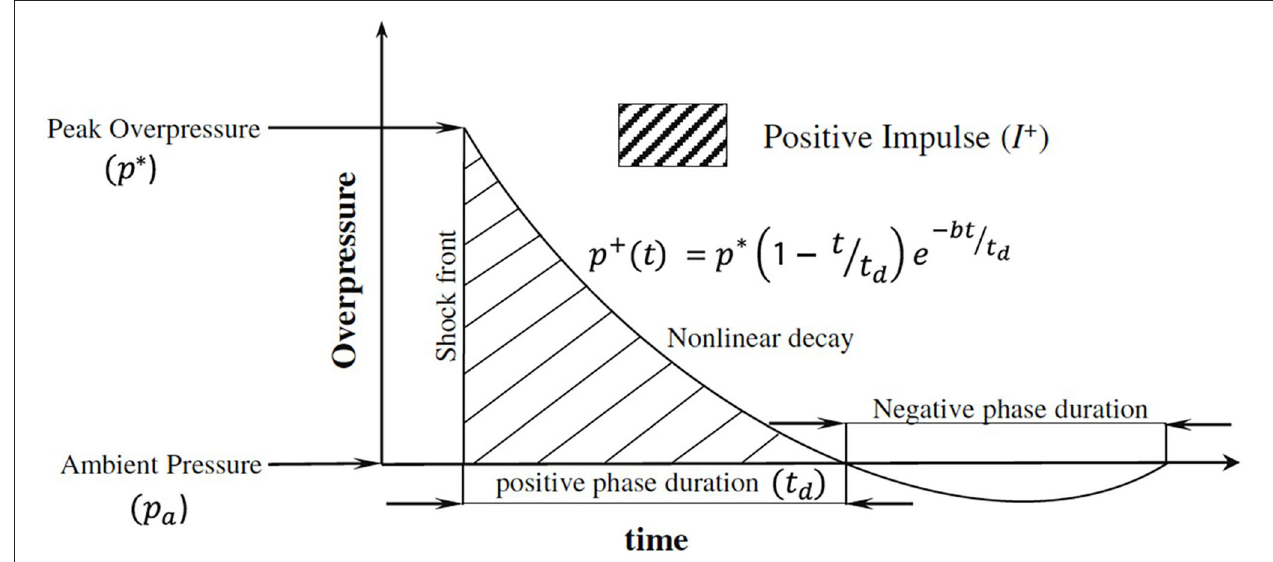
FIGURE 2 | Planar Friedlander waveform adapted from Chandra et al. (37). In the figure, the instantaneous overpressure p + at time t is defined using the peak overpressure p ∗ , positive phase duration t d , and decay constant b